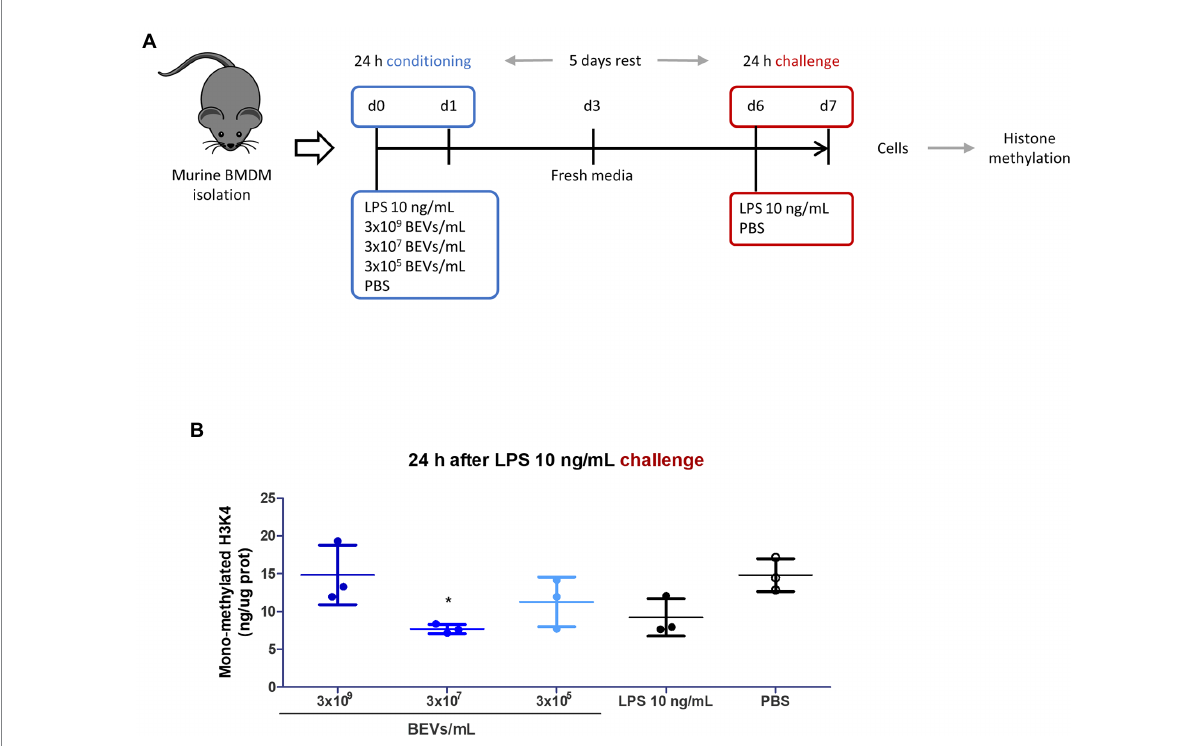
FIGURE 5 Histone mono-methylation (H3K4me1) as an epigenetic signature of Bt BEV modulation of innate immunity. (A) Experimental plan. (B) Methylation of histone proteins from Bt BEV- or LPS-conditioned BMDM 24 h after exposure to LPS (10 ng/ml) was quantified using an ELISA-based colorimetric kit and results were expressed as ng of H3K4me1 per μ g of total protein. Non-conditioned BMDM (PBS) were used as the reference group for statistical analysis. Graph depicts mean ± SD values. * p <